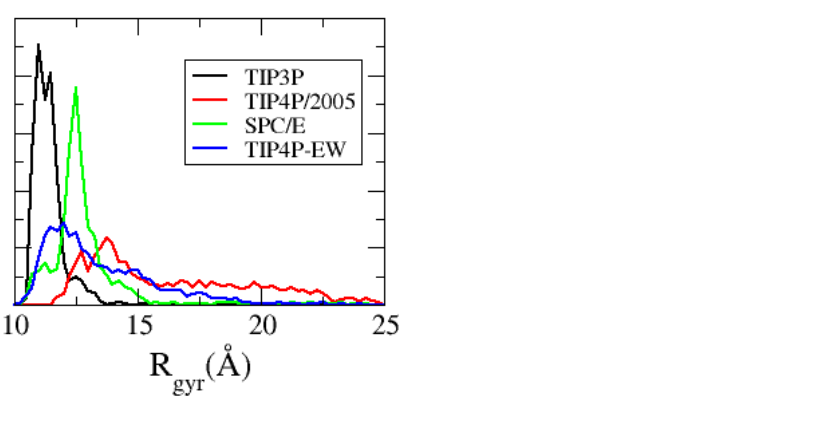
Figure 9. Radius of gyration distribution of the ACTR peptide, found in the simulations with the TIP3P (black line), SPC/E (green), TIP4P-EW (blue) and TIP4P/2005 (red) water